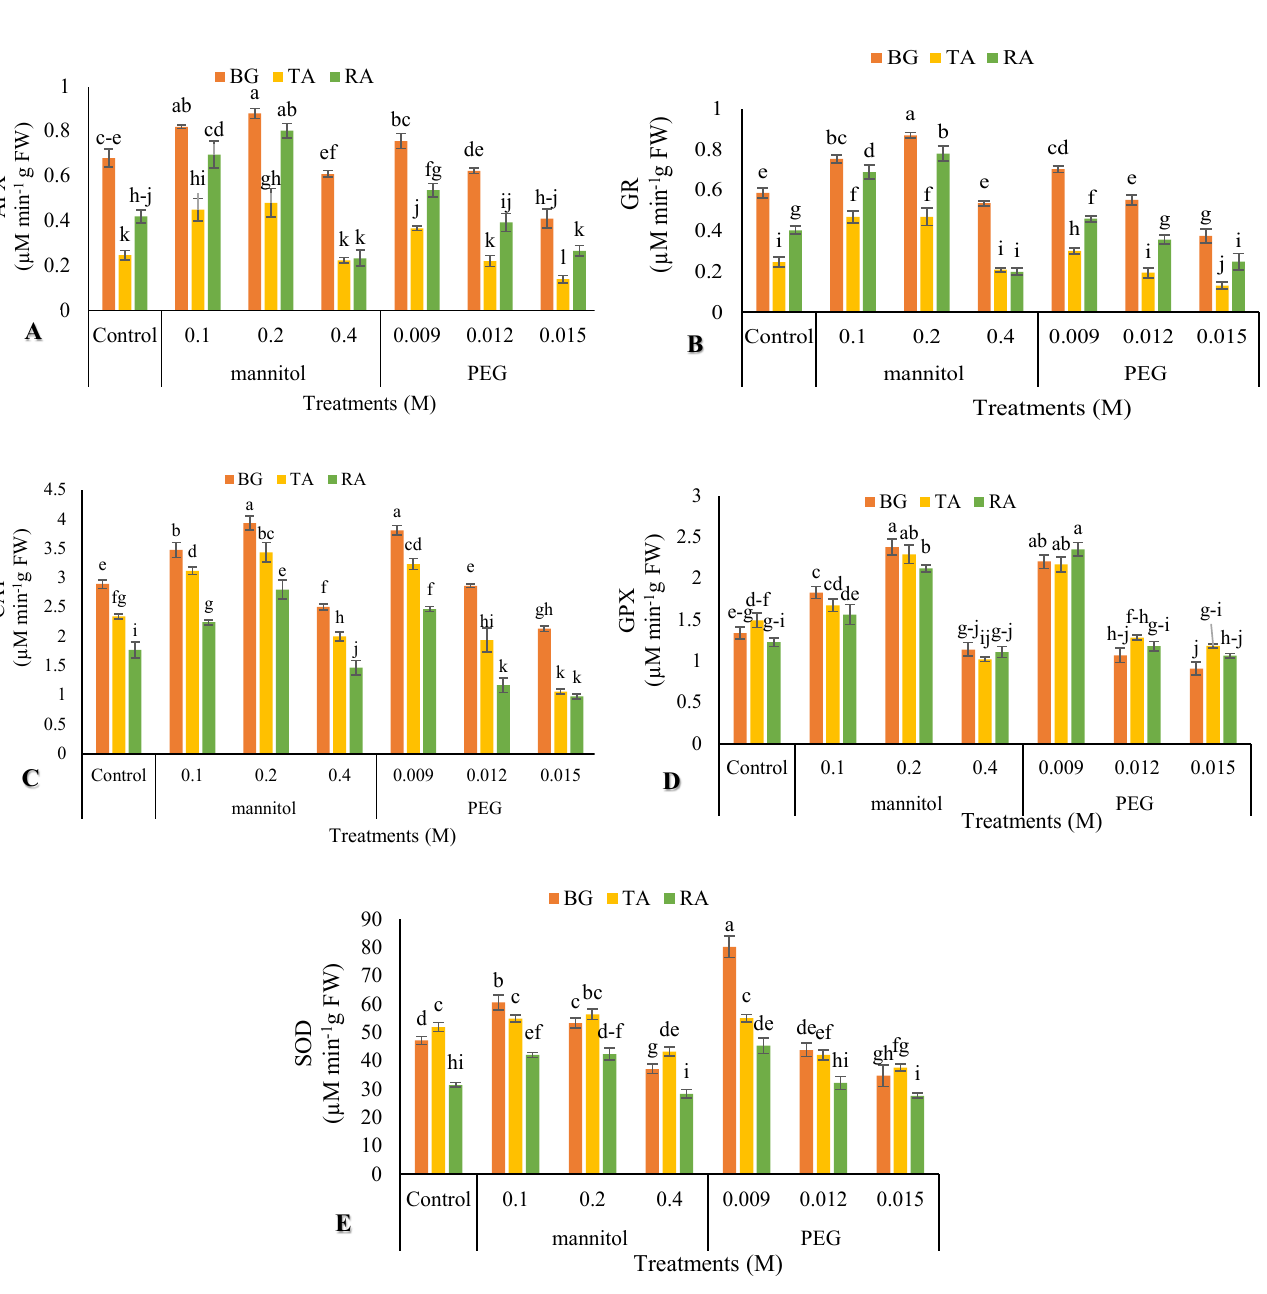
Figure 2. Effects of PEG and mannitol on ascorbate peroxidase (APX) activity ( μ M min − 1 mg FW) ( A ), glutathione reductase (GR) activity ( μ M min − 1 mg FW) ( B ), catalase (CAT) activity ( μ M min − 1 mg FW) ( C ), guaiacol peroxidase (GPX) activity ( μ M min − 1 mg FW) ( D ), and superoxide dismutase (SOD) activity ( μ M min − 1 mg FW) ( E ) in Cucurbita sp. genotypes under in vitro condition. The different letters are significantly different based on Duncan’s multiple range test ( p ≤ 0.05).